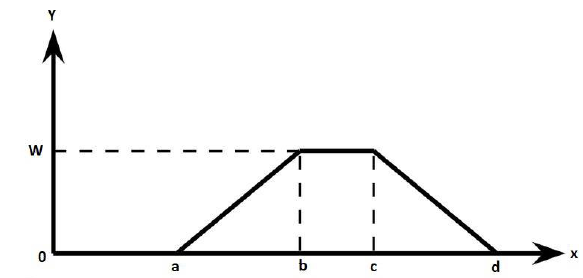
Figure 3. A generalized trapezoidal fuzzy.